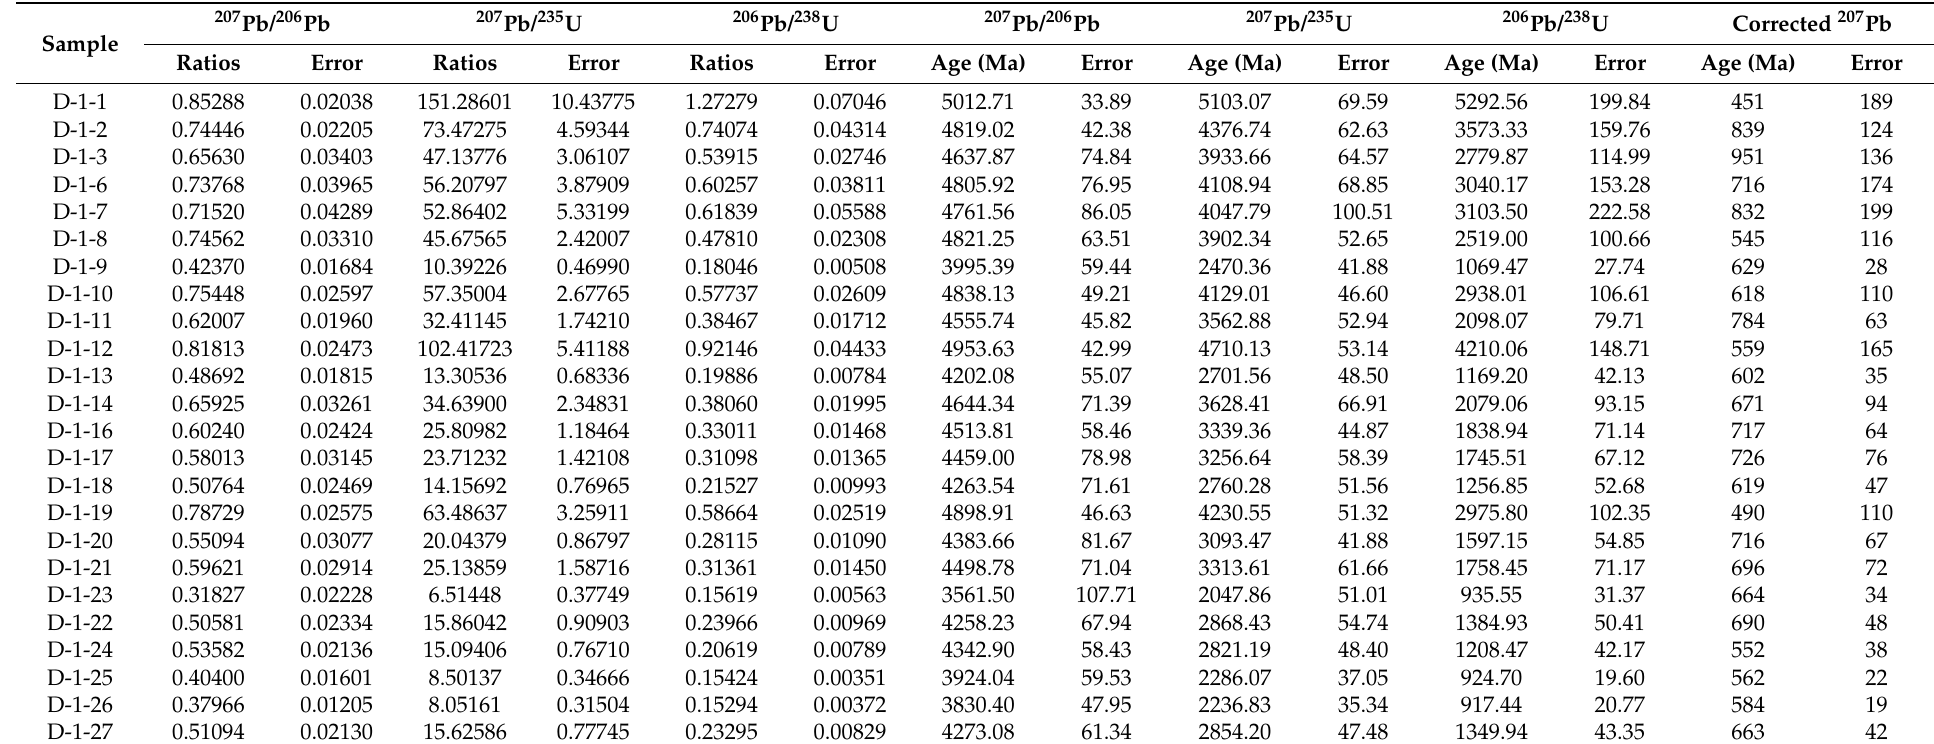
Table 1. Monazite U–Pb isotopic data of the sample D-1 from the Bayan Obo